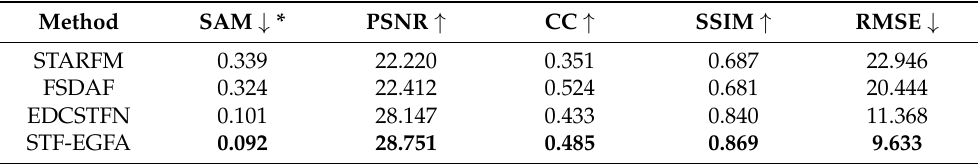
Figure 13. Experimental results based on the AHB dataset for spatiotemporal fusion: ( a , f ) Ground truth image; ( b , g ) STARFM method results; ( c , h ) FSDAF method results; ( d , i ) EDCSTFN method results; and ( e , j ) STF-EGFA method results. Table 2. Objective evaluation results for the AHB test